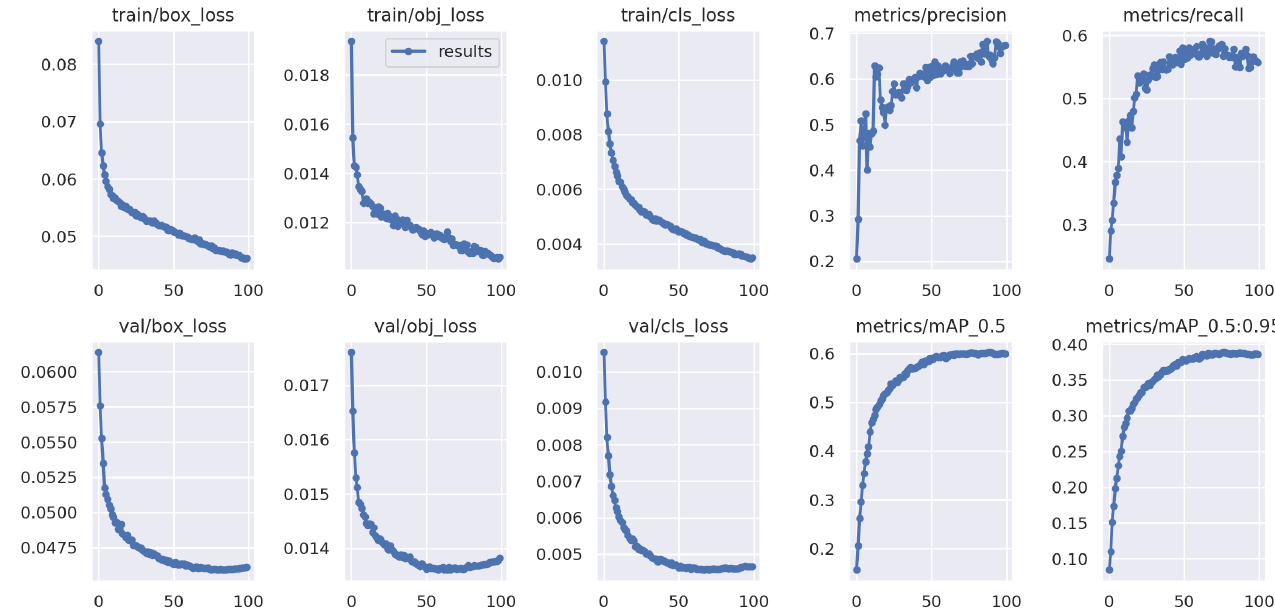
Figure 9. The P–R curve of the suggested model on the VisDrone2021 test set.